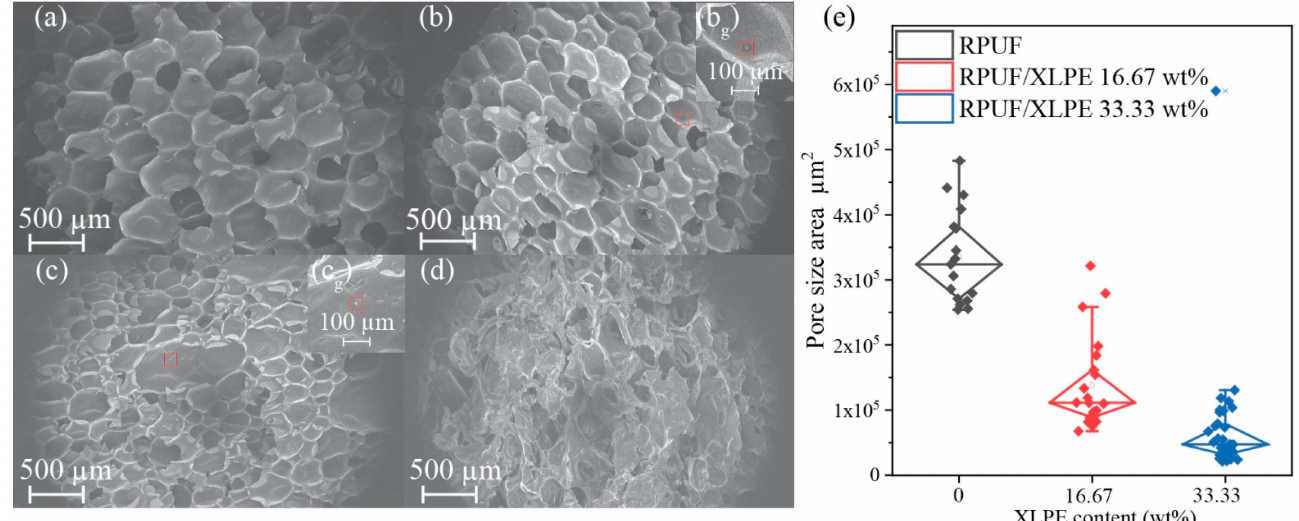
Figure 5. The SEM images for foams of the ( a ) RPUF, ( b ) RPUF/XLPE 16.67 wt%, ( b g ) XLPE microparticle fillers with 100 µ m scalebar, ( c ) RPUF/XLPE 33.33 wt%, ( c g ) XLPE microparticles, and ( d ) RPUF/XLPE 47.37 wt%, ( e ) whisker box plot of pore size area vs. XLPE